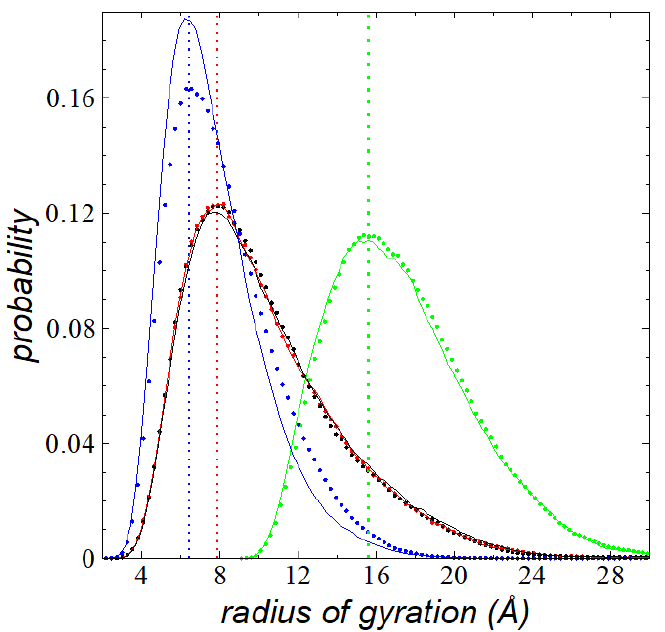
Figure 7. Histograms of R g of thin liquid layers of melted polyethylene chains (C 200 ) in a liquid– vacuum equilibrium at their t c at 673.15 K. Black and red points represent the components in the lateral directions to the interfacial surface, blue points represent the normal direction, and green points represent the total values. Continuous lines represent the histograms for the interfacial chains of a wider thin layer than the layer at its t c containing 288 chains; the color code in continuous lines is the same as the lines of points. Vertical lines represent the mode of the